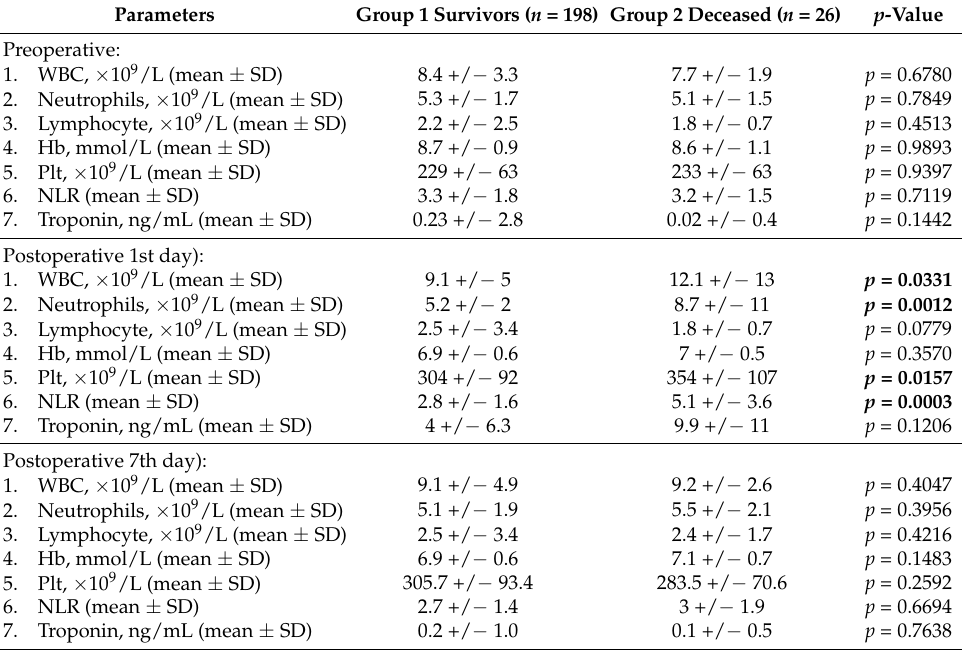
Table 2. Perioperative laboratory